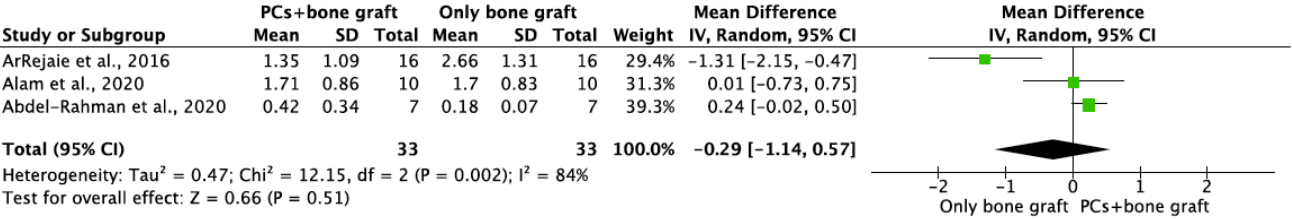
Figure 3. Random-effect meta-analysis evaluating MBL in both aspects at 12 months in immediate implants procedures with PCs vs. no PCs.